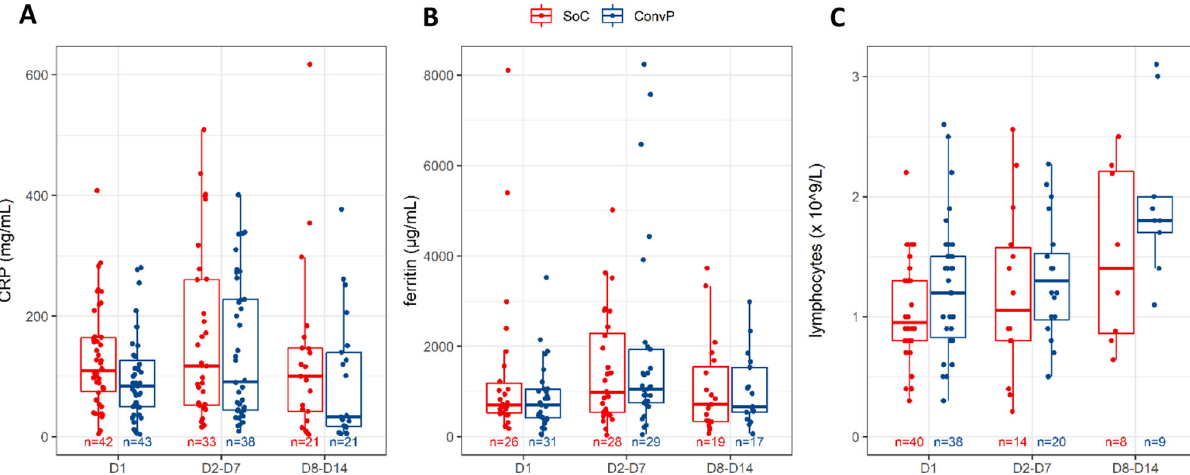
Fig. 3 In fl ammatory markers in patients. A CRP. B Ferritin. C Lymphocytes. CRP, ferritin and lymphocytes were measured* in the serum of COVID-19 patients (standard of care: red; convalescent plasma: blue) on day 1 of enrollment, between days 2 – 7 and days 8 – 14 after enrollment. Reported data are the highest value for CRP and ferritin, and the lowest value for lymphocytes. Box plots indicate median (middle line), 25th, 75th percentile (box), and 5th and 95th percentile (whiskers), as well as outliers (single points). *Only measured if it was part of routine